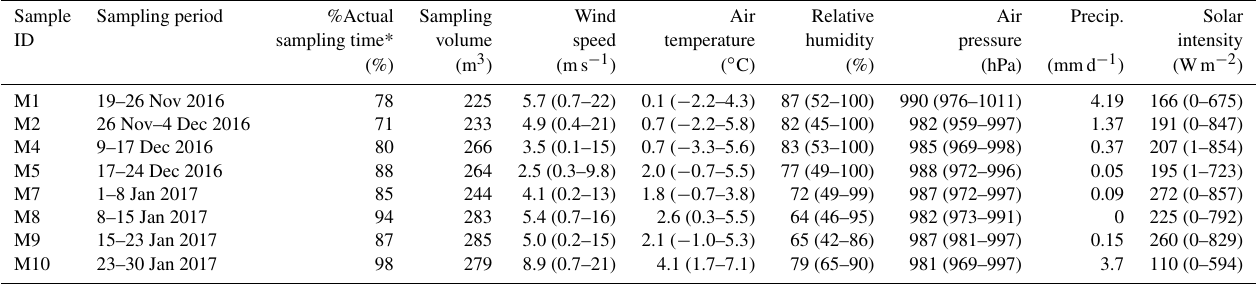
Table 1. Sampling periods and meteorological conditions for individual samples (Gao et al., 2020). Sample Sampling